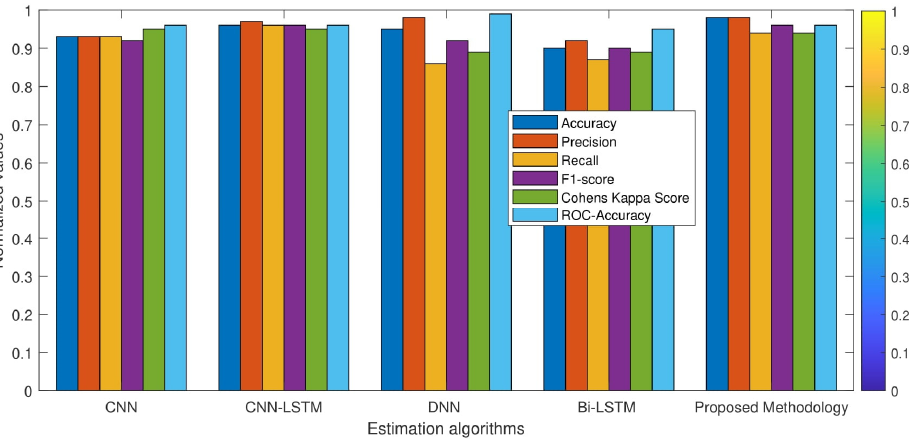
Figure 12. Performance analysis of optimized proposed methodology with respect to existing deep learning algorithms. Table 13. Results of the proposed architecture with different Mean Test Scores using Grid Search Optimization.